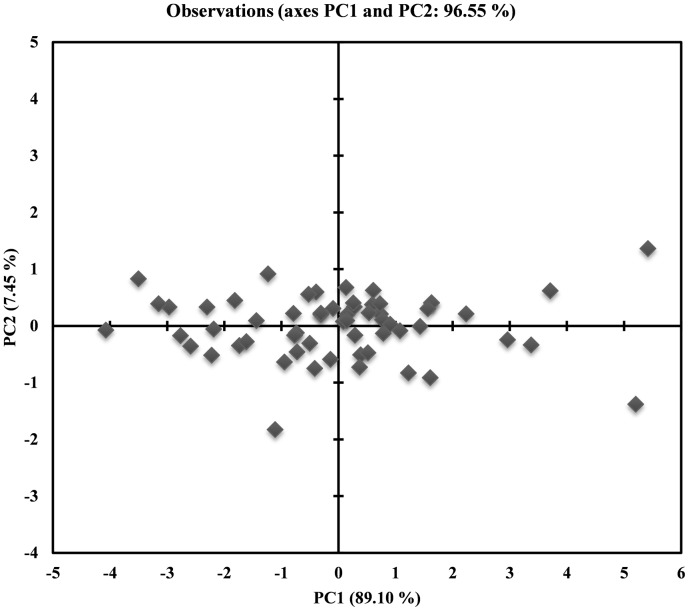
A Scatter plot of the optimal codon distribution on the first and second principal axes are derived from PCA analysis.The first axis (PC1) explained 89.90% of total variance, while the second axis (PC2) accounted for 7.45% of total variance.